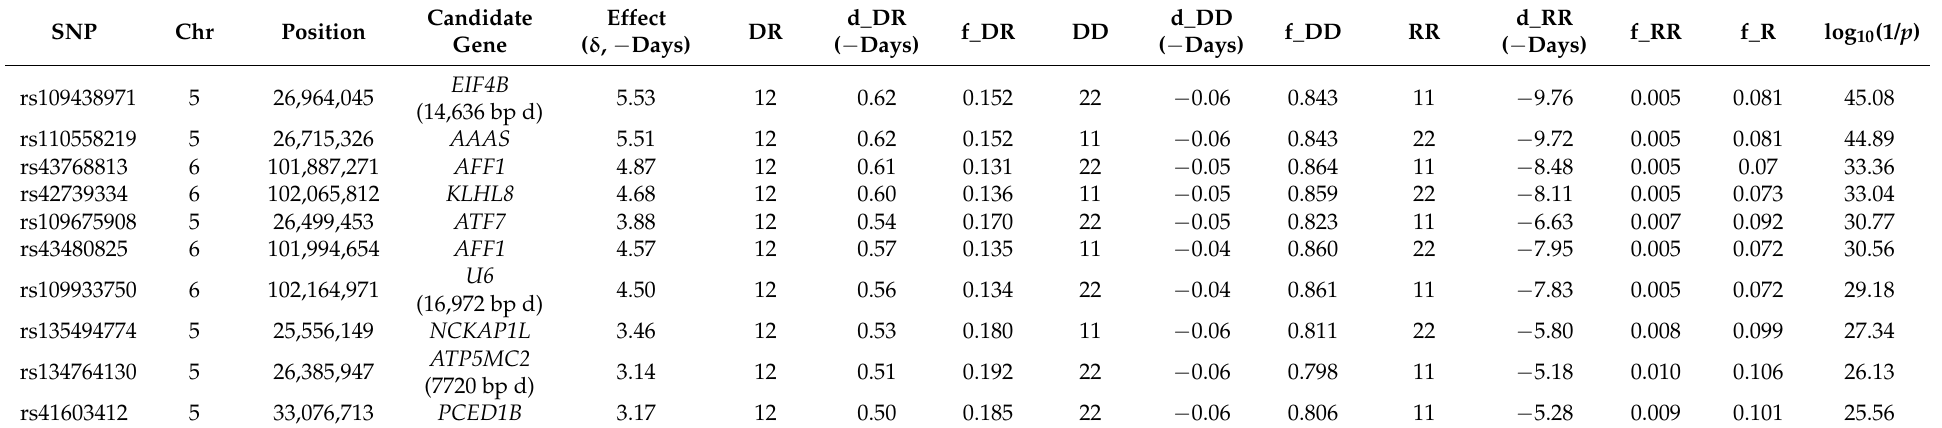
Table 2. Top 10 significant dominance effects for